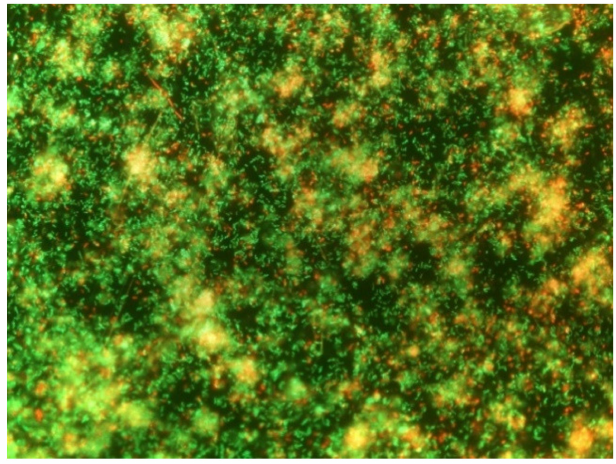
Figure 1. Representative image of B. safensis biofilms formed after one week of incubation, observed with Live/Dead BacLight staining by direct epifluorescence microscopy (20 ×